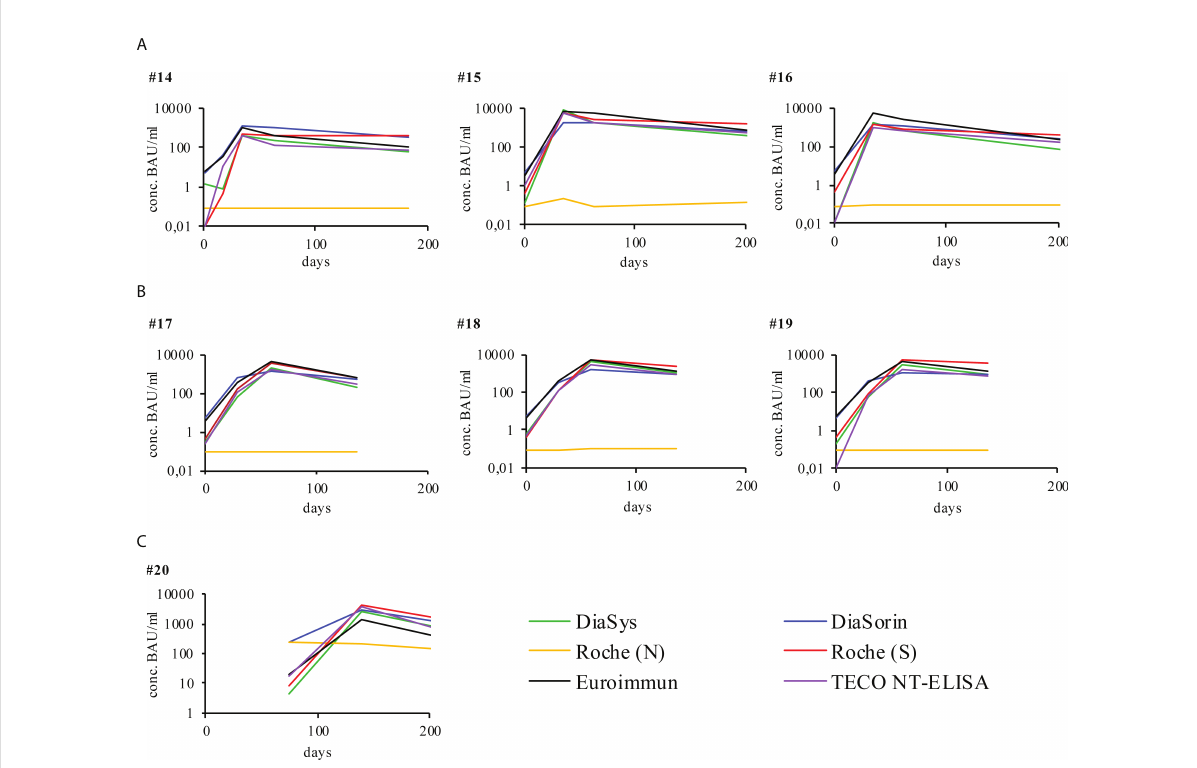
FIGURE 2 Individual humoral antibody immune response of vaccinated participants monitored over respective days post vaccination with different immuno-assays. All signals were measured in BAU/ml as indicated by respective manufacturer (y-axis), except for Roche (N), the latter was measured in cut-off-index (COI). The respective cut off values of the different assays are reported in Table 1. X-axis represents duration of evaluation in days. Participants were vaccinated with either (A) Comirnaty ® , BioNTech/P fi zer or (B) Spikevax ® , Moderna. Participant 20 was vaccinated with Comirnaty ® after COVID-19 recovery, represented by a later start of vaccination speci fi c data (C) . For a more detailed analysis on of the participants please also refer to Supplement Table